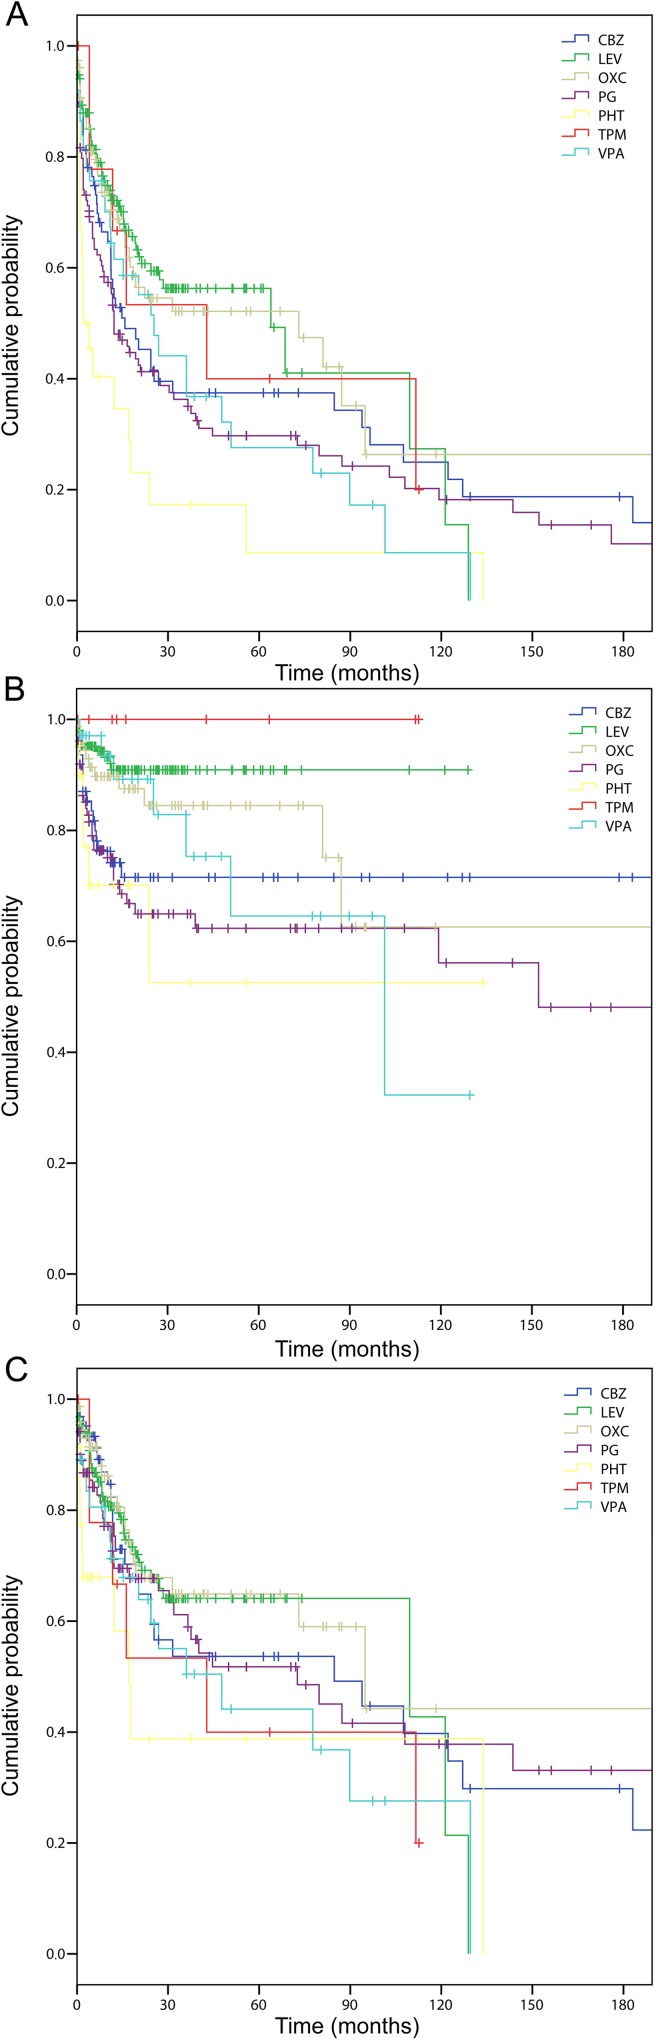
Time to treatment withdrawal by assigned drug in general (A), for lack of efficacy (B), and for poor tolerability/toxicity (C). CBZ = Carbamazepine; LEV = Levetiracetam; OXC = Oxcarbazepine; PG = Phenytoin; PHT = Phenobarbital; TPM = Topiramate; VPA = Valproate.